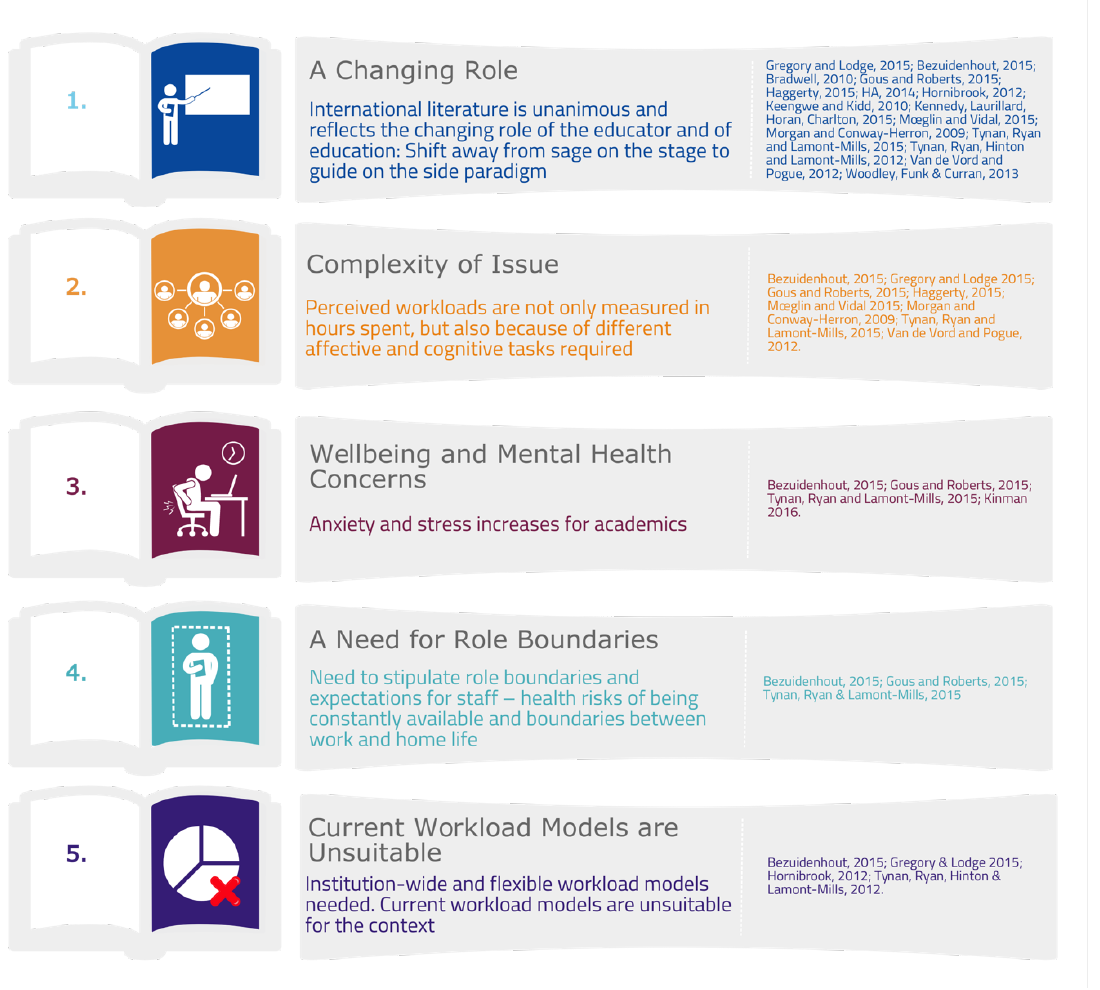
Figure 3: Themes in the Literature As per the infographic, international literature drawn from Australia, South Africa, the UK, New Zealand, Ireland, the UK, France and the USA unanimously agrees that the role of the educator, and indeed of education, is changing. We are seeing the shift away from sage on the stage to guide on the side paradigm. However, as per figure 2, it is clear that the multiple roles required in becoming the guide on the side in moving towards this new paradigm is extremely complex. These complexities can cause anxiety and stress for academics, as no doubt many currently feel with how Covid is impacting their teaching. In particular with the blurred lines between home and work life during the restrictions due to the pandemic, there are definite needs for role boundaries. Finally, the literature pertaining to current workload models being unsuitable was written pre-Covid; there is again no doubt that they are possibly less so